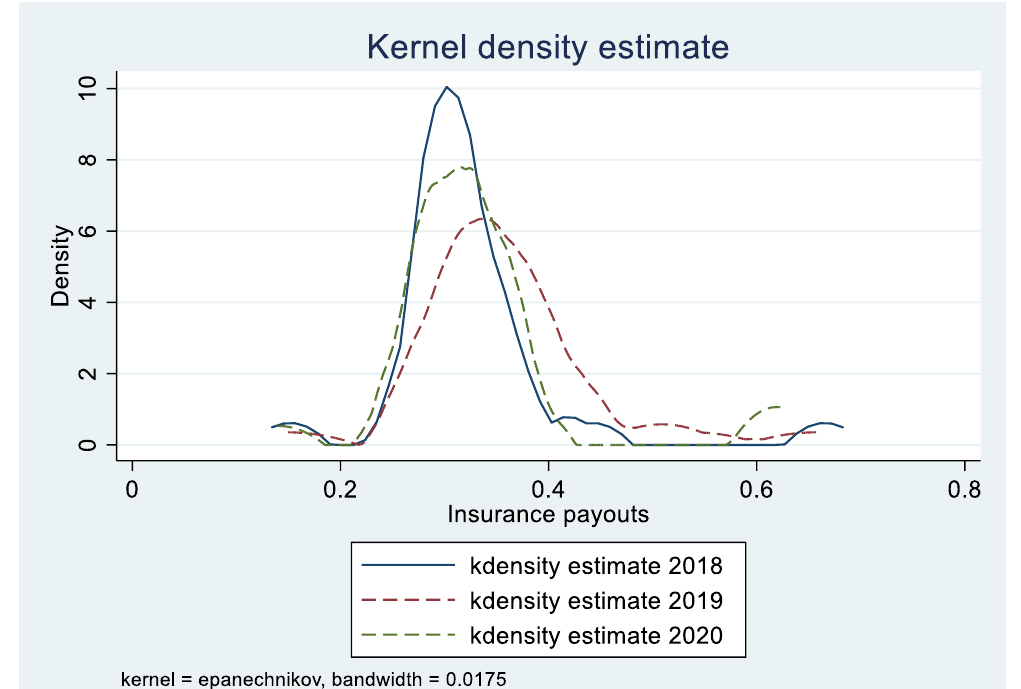
Figure 1. Dynamic evolution trend of the payout rate of TCI.